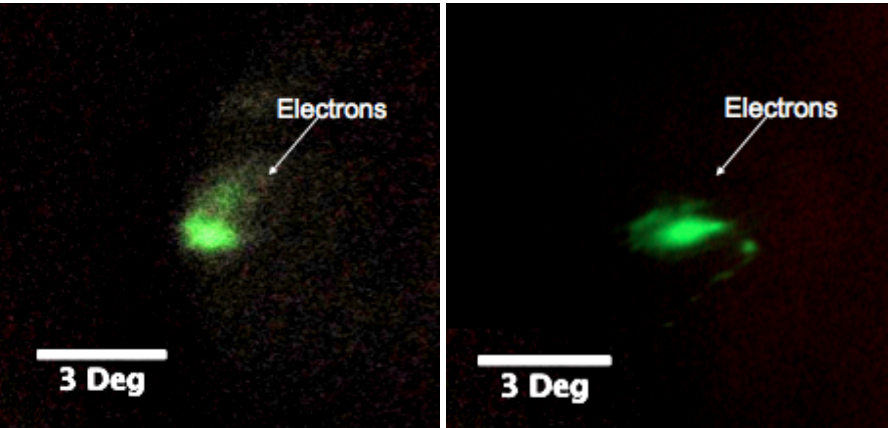
Figure 16. Image of the first accelerated electron bunches obtained at FLAME during the SITE experimental campaign. Images were obtained with a LANEX screen placed at a distance of 40 cm downstream along the laser propagation direction and show generation of collimated electron bunches with mrad range